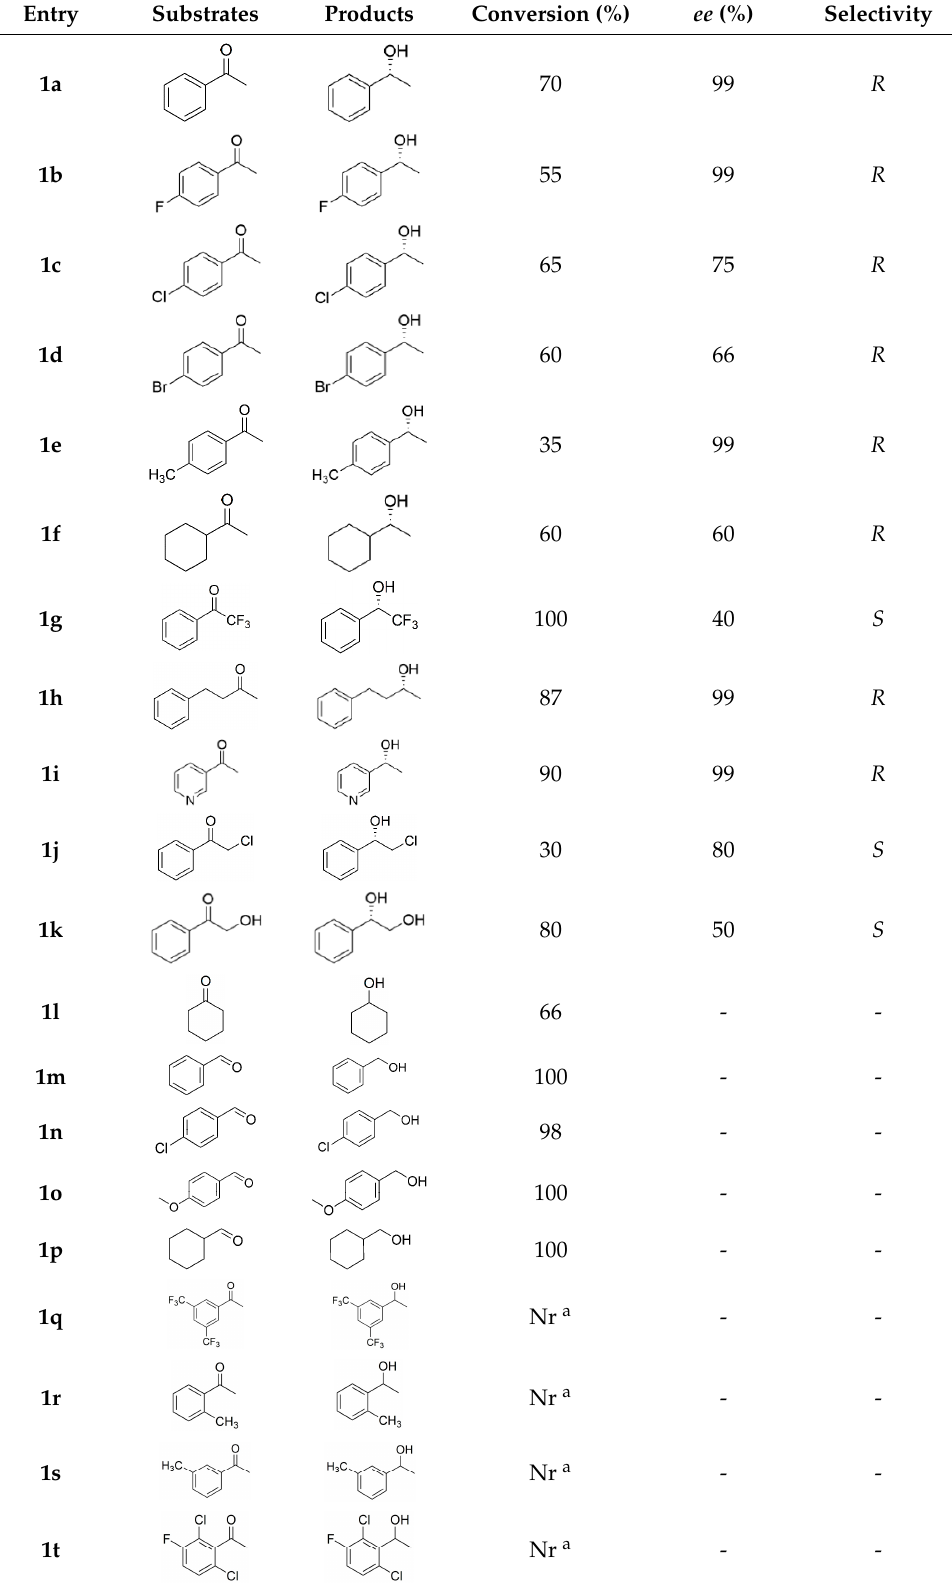
Table 2. Reduction of various ketones or aldehydes by B. cereus TQ-2 whole cell biocatalyst .